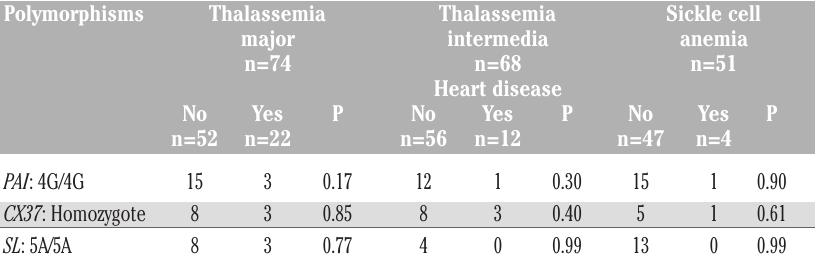
Table 3. P values calculated for the polymorphism between patients with and without heart disease. Polymorphisms